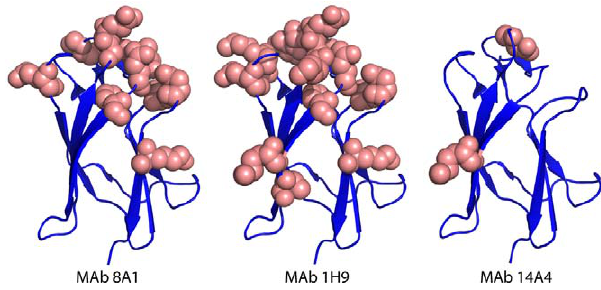
Figure 4. Mapping EDIII epitopes for MAbs 8A1, 1H9 and 14A4. The Figure depicts the positions of mutations that reduced